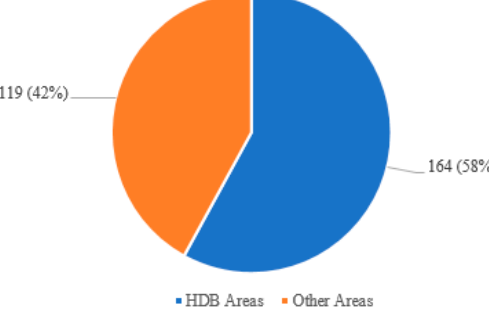
Figure 4. Getai in the Housing & Development Board (HDB)